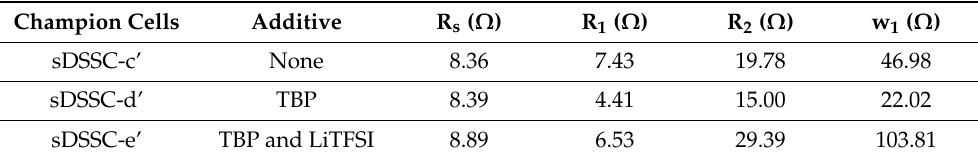
Figure 5. Nyquist plots of EIS spectra for the sDSSC-c’, sDSSC-d’, and sDSSC-e’, measured in an open-circuit condition under the illumination of simulated AM 1.5 solar light. Inset shows the equivalent circuit for sDSSCs; where CPE indicates constant phase element. Table 5. Fitted resistances for the sDSSC-c’, sDSSC-d’, and sDSSC-e’ based on the m-MTDATA- solidified MPII with or without additives.